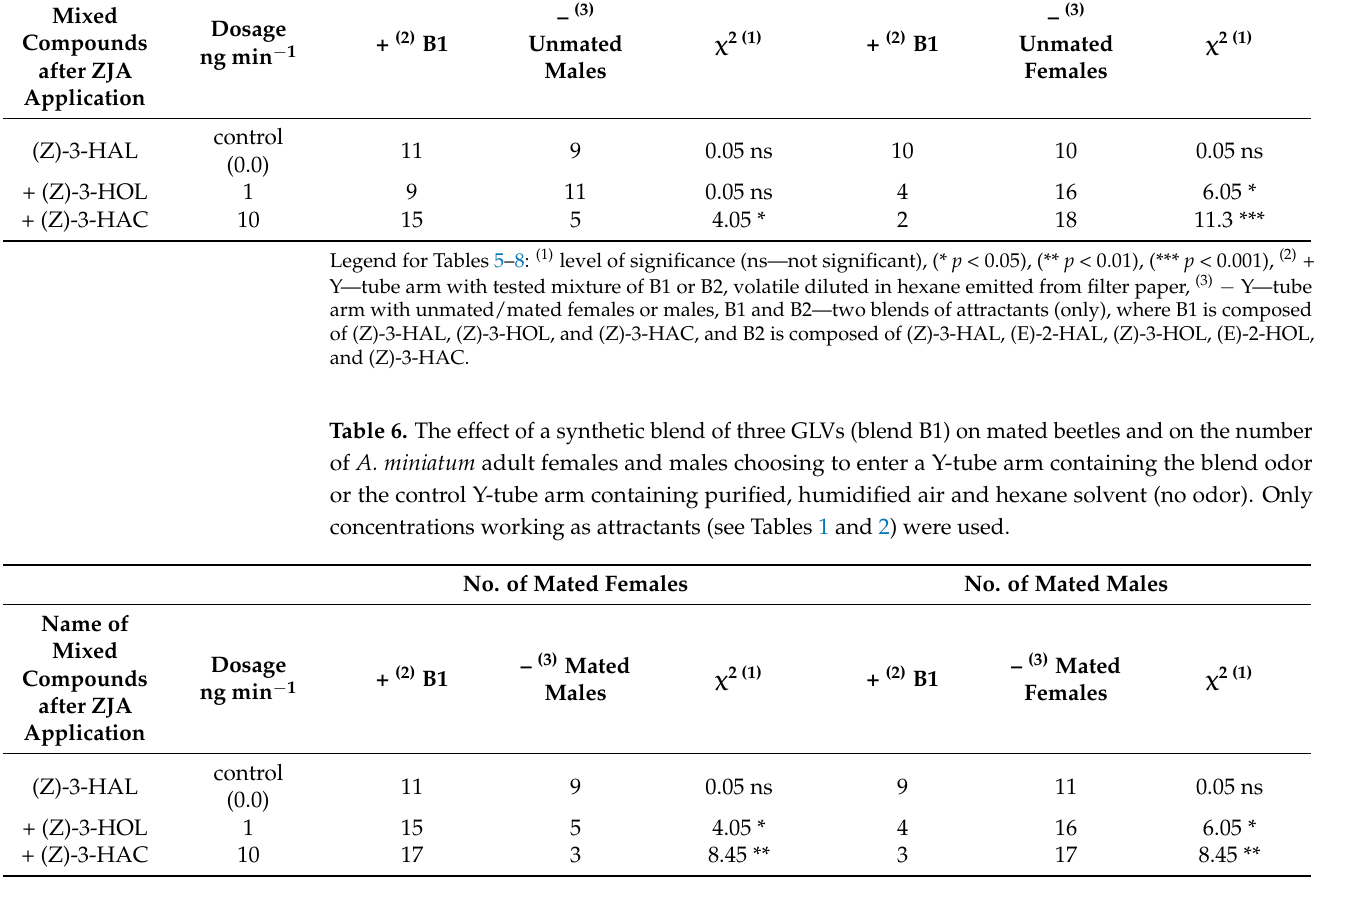
Table 5. The effect of a synthetic blend of three GLVs (blend B1) on unmated beetles and on the number of A. miniatum adult females and males choosing to enter a Y-tube arm containing the blend odor or the control Y-tube arm containing purified, humidified air and hexane solvent (no odor). Only concentrations working as attractants (see Tables 1 and 2) were used.